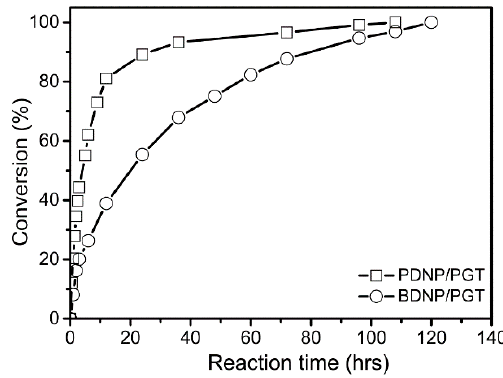
Figure 3. Conversion plot for Cu-free azide-alkyne 1,3-DPCA reaction of REPs/PGT prepolymer at 60 °C.